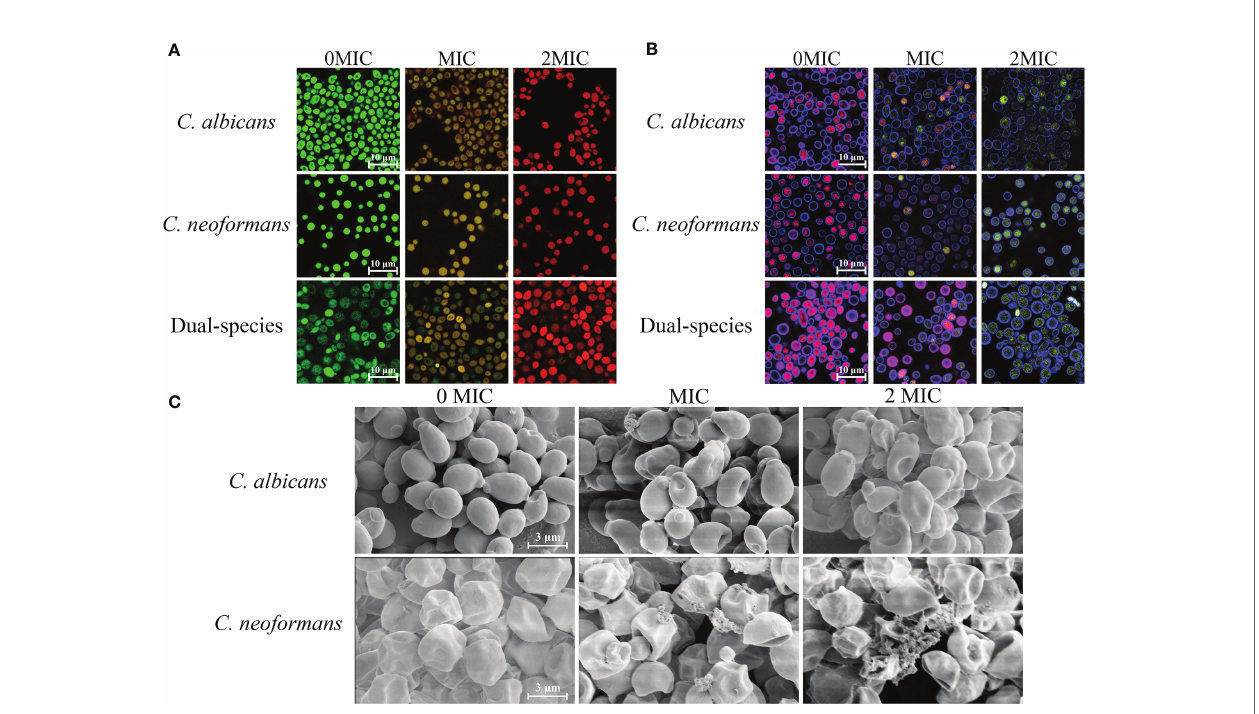
FIGURE 2 | Effects of paeonol on the cell membrane integrity (A) , metabolic activities (B) , and cell morphology (C) of C. albicans SC5314 and C. neoformans H99 mono- and dual-species. (A) C. albicans SC5314, C. neoformans H99, and dual-species cells exposed to paeonol at 0, MIC, and 2 MIC at 30°C for 4 h were shown using a confocal laser scanning microscope (CLSM) in combination with SYTO 9 and propidium iodide. (B) After C. albicans SC5314, C. neoformans H99 mono- and dual-species were incubated with paeonol at 0, MIC, and 2 MIC for 24 h at 30°C; images were captured using CLSM by combining FUN ® 1/Calco fl uor ® White M2R dyes. (C) C. albicans SC5314 and C. neoformans H99 were exposed to paeonol at different concentrations of 0, MIC, and 2 MIC at 30°C for 6 h and assessed using fi eld emission scanning electron microscope (FESEM). Scale bars represent 10 and 3 m m for CLSM and FESEM images,